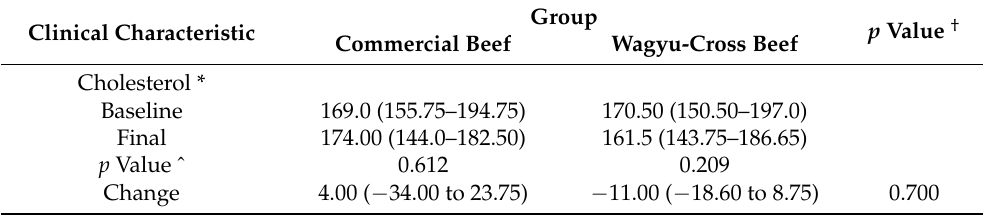
Table 4. Comparison of serum lipid parameters and atherogenic indices before and after food intervention 1